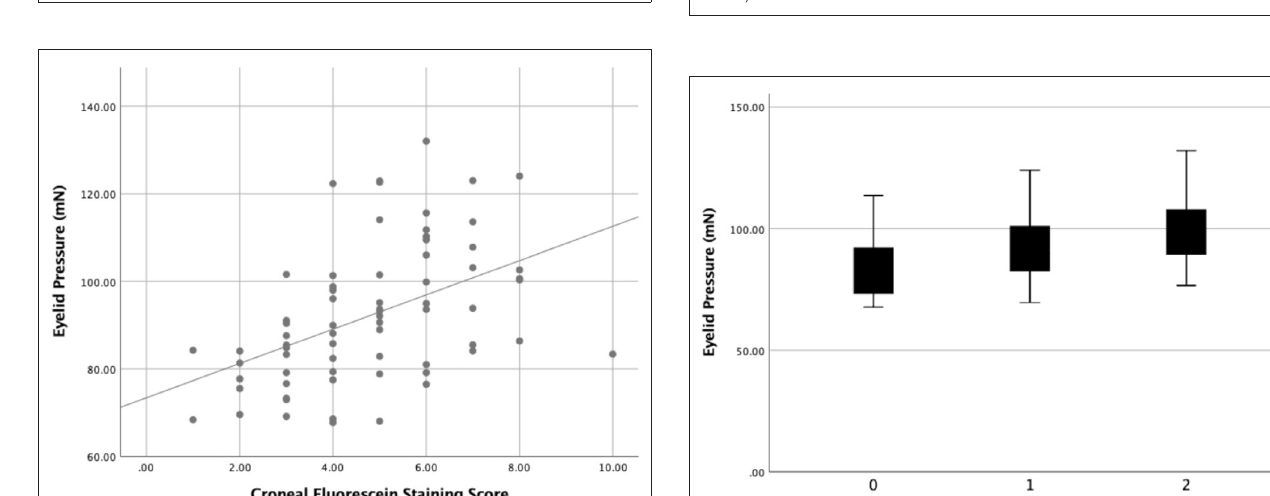
FIGURE 7 | The eyelid pressure of different levels of lid margin abnormality. Statistical significance was assessed between the 2 levels (r = 0.408, P = 0.011).